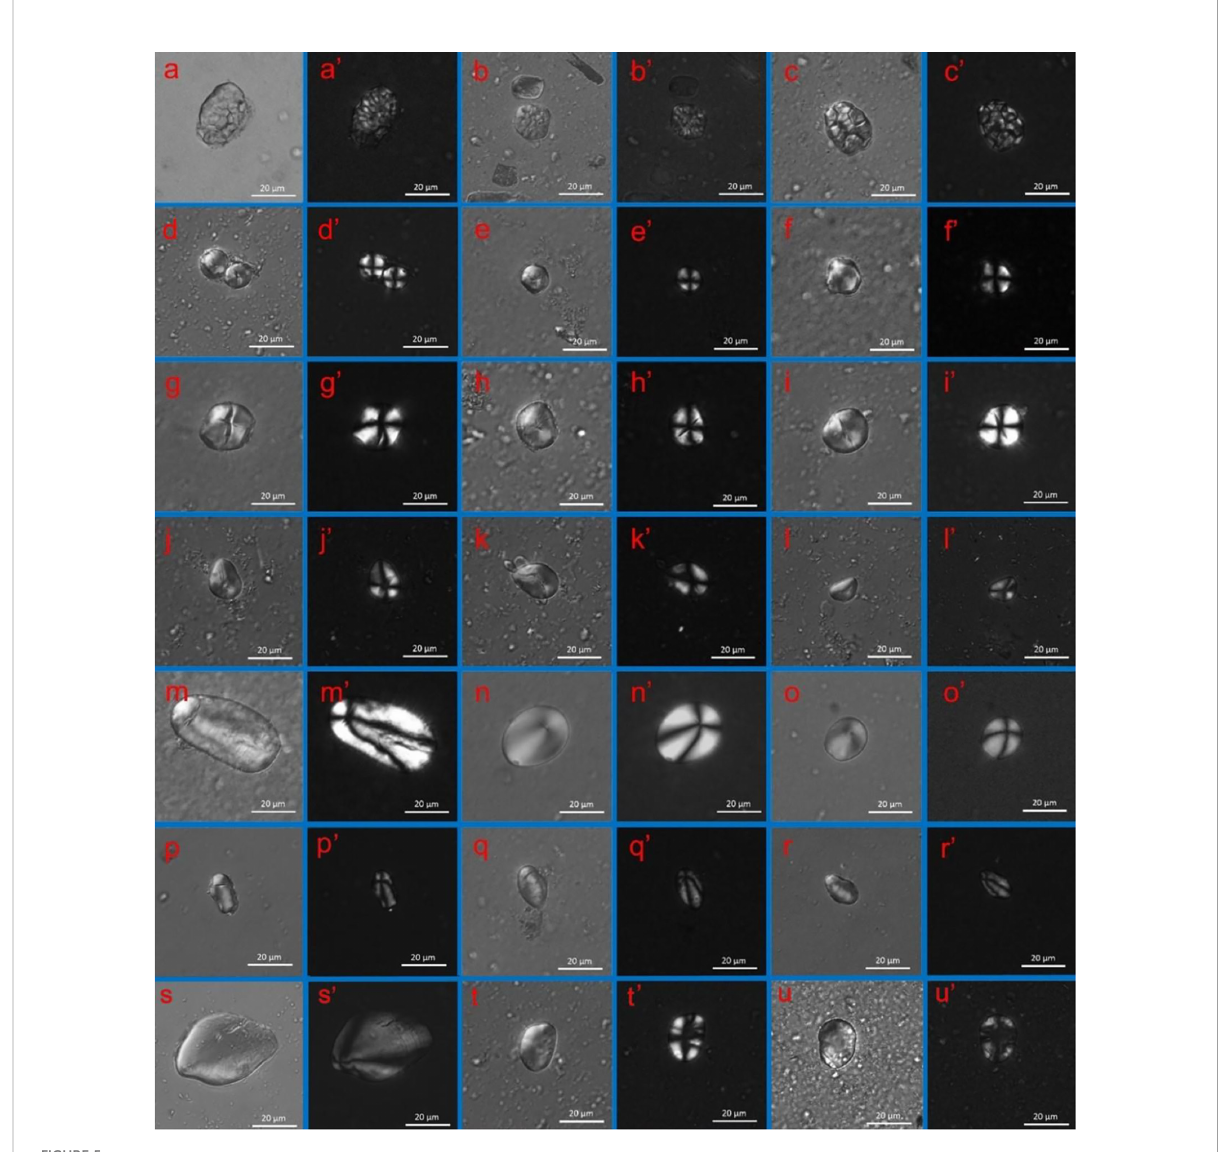
FIGURE 5 Starch grains retrieved from Qujialing Pottery samples under DIC and polarized fi lters (scale bar: 20 m m): (A-C ’ ) rice ( Oryza sativa) (D-F ’ ) millet ( Setaria italica or/and Panicum miliaceum ) ; (G-I ’ ) job ’ s tears ( Coix lacryma-jobi ); (J-L ’ ) acorn ( Quercus sp.) ; (M-O ’ ) lotus root ( Nelumbo nucifera ); (P-S ’ ) starch grains from underground storage organs ; (T-U ’ ) bean ( Vigna sp. or/and Vicia